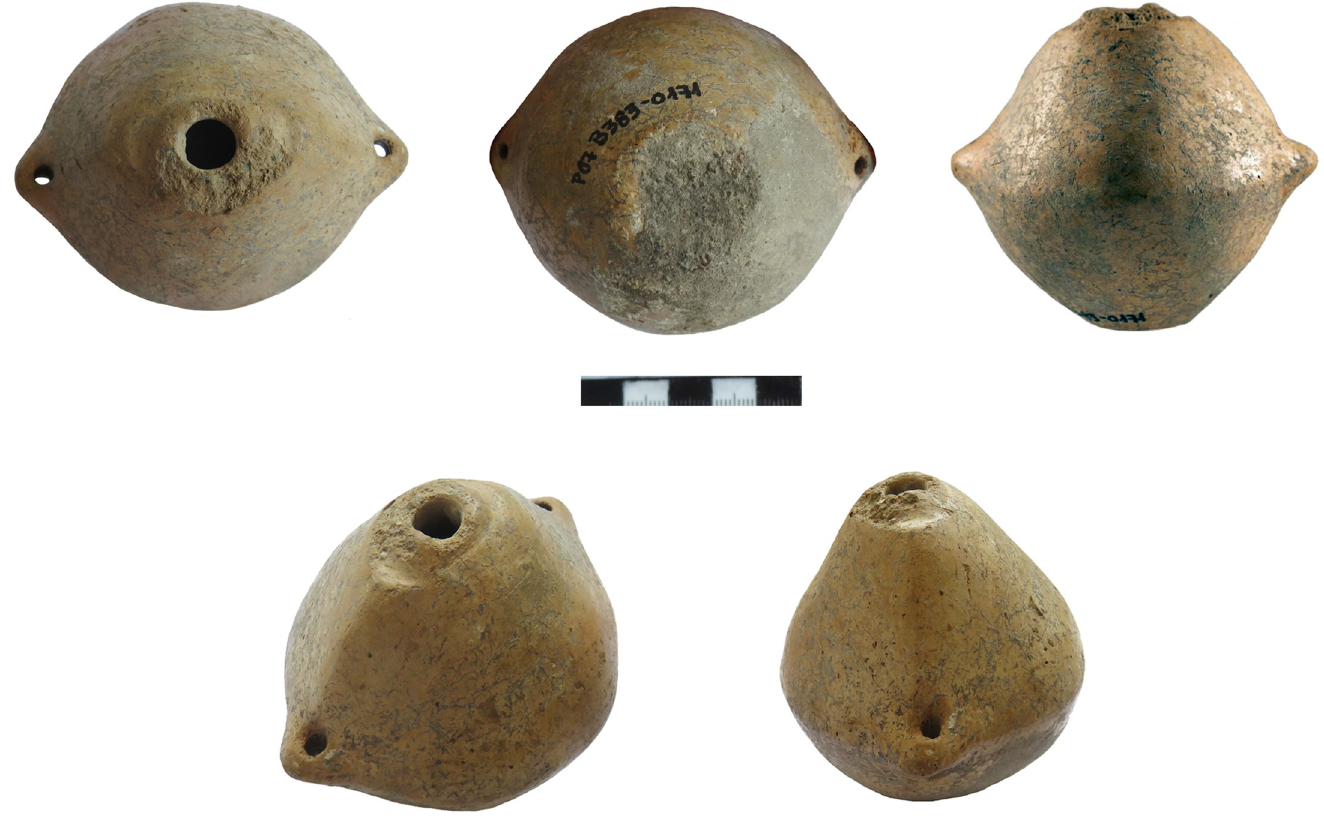
Fig 6. P07B3830171 (Photos S. Hansen, D. Steiniger).